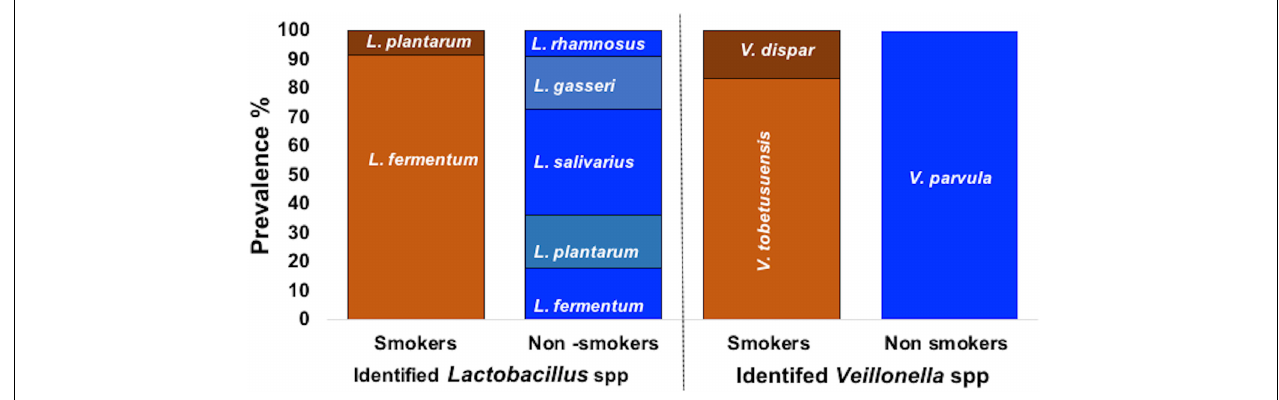
FIGURE 1 | Prevalence of Lactobacillus spp., and Veillonella spp. in smokers and non-smokers groups.